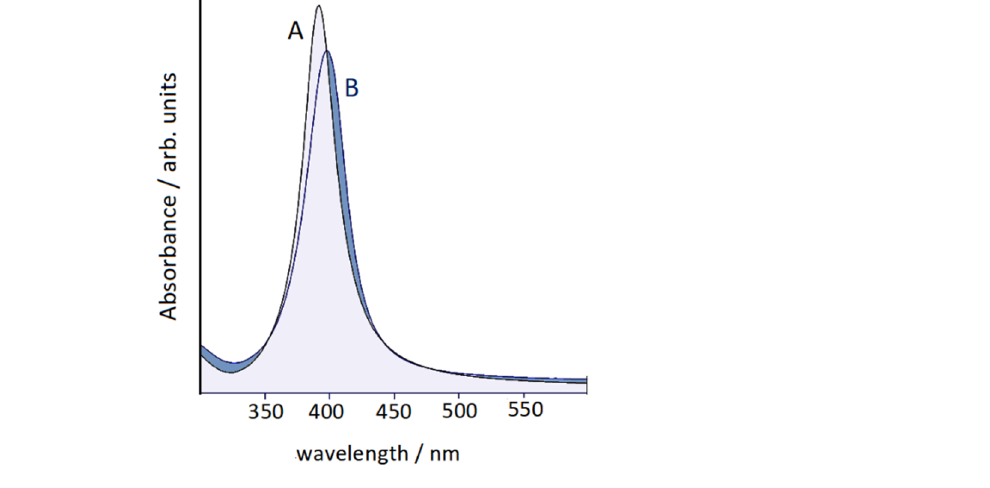
Table 1. Vibrational frequencies (cm -1 ) of both experimental and calculated spectra.